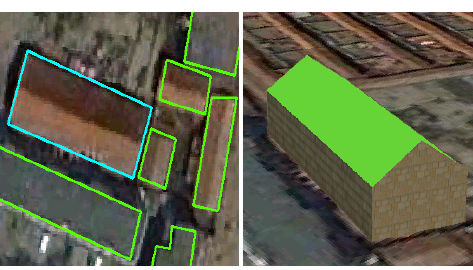
Figure 1. Example of reconstruction of buildings